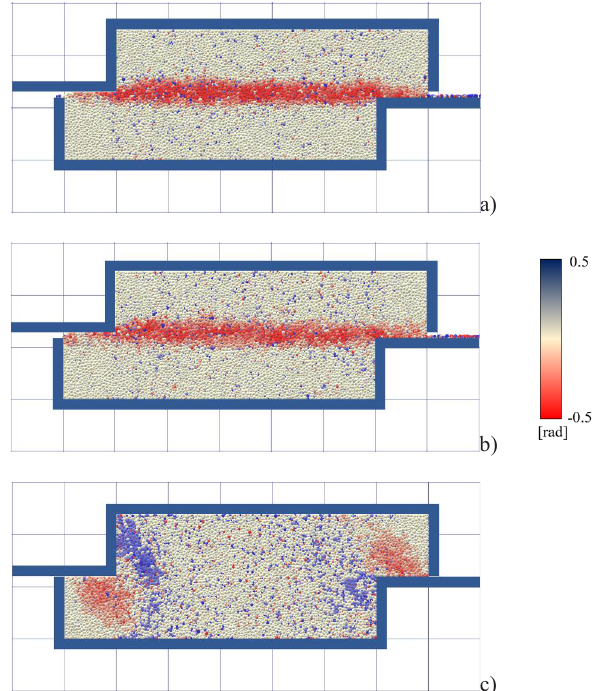
Figure 14: Distribution of sphere rotations at the final state of the test for different initial void ratios: a) e = 0.53, b) e = 0.60 and 0 0 c) e = 0.75 (σ = 200 kPa, d = 0.5 mm) (red colour – clockwise 0 0 50 rotations, blue colour – anti-clockwise rotations) (colour online) Figure 13: Front view of the specimen at the final state for different initial void ratios: a) e = 0.53, b) e = 0.60 and c) e = 0.75 (σ = 0 0 0 0 200 kPa, d = 0.5 mm) (the dark/light grey stripes were perfectly 50 vertical at the beginning of the tests).